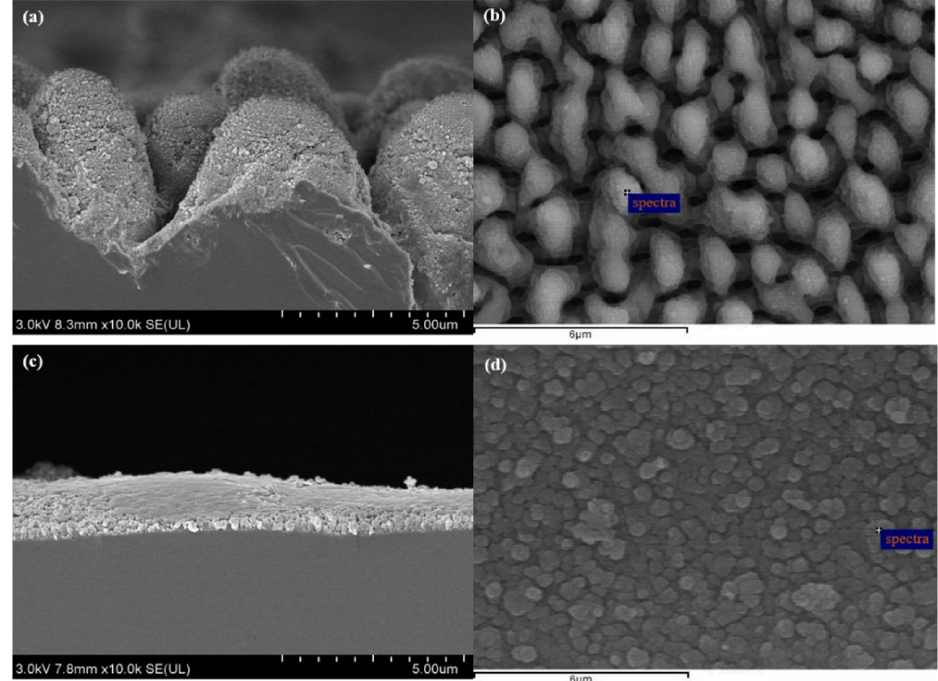
Figure 2. SEM images of Se ‐ doped microstructure fabricated by ( a , b ) fs laser and ( c , d ) ps laser: ( a , c ) and ( b , d ) are the side and top view images. (The cross ‐ section used for side image is obtained by brittle fracture of liquid nitrogen).